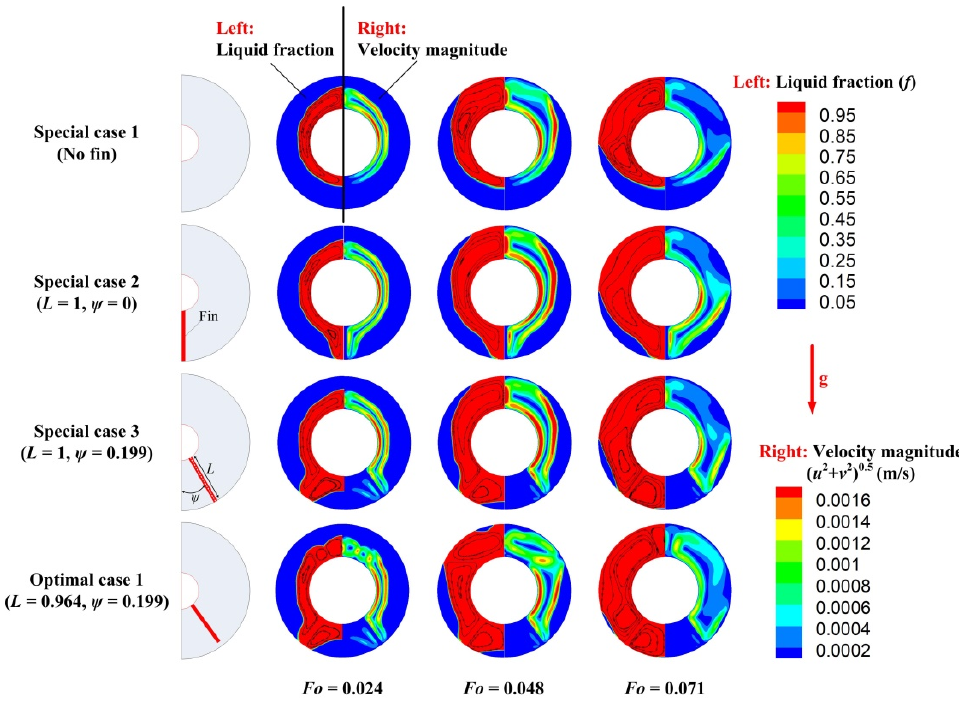
Figure 7. Contour maps of liquid fraction and velocity magnitude for Special Cases 1–3 and Optimal Case 1.